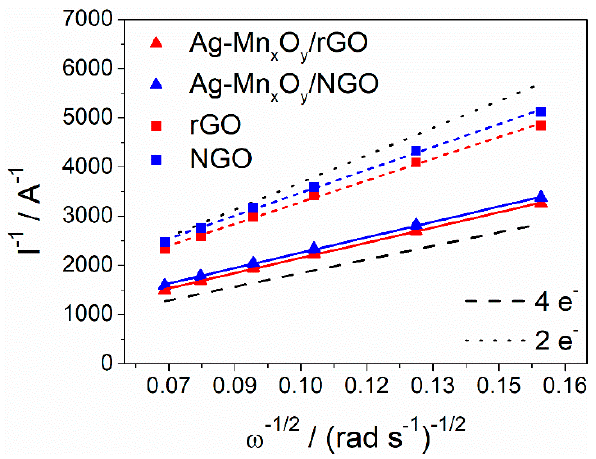
Figure 7. Koutecky–Levich plot of Ag-Mn x O y /rGO, Ag-Mn x O y /NGO catalysts, and blank support materials.